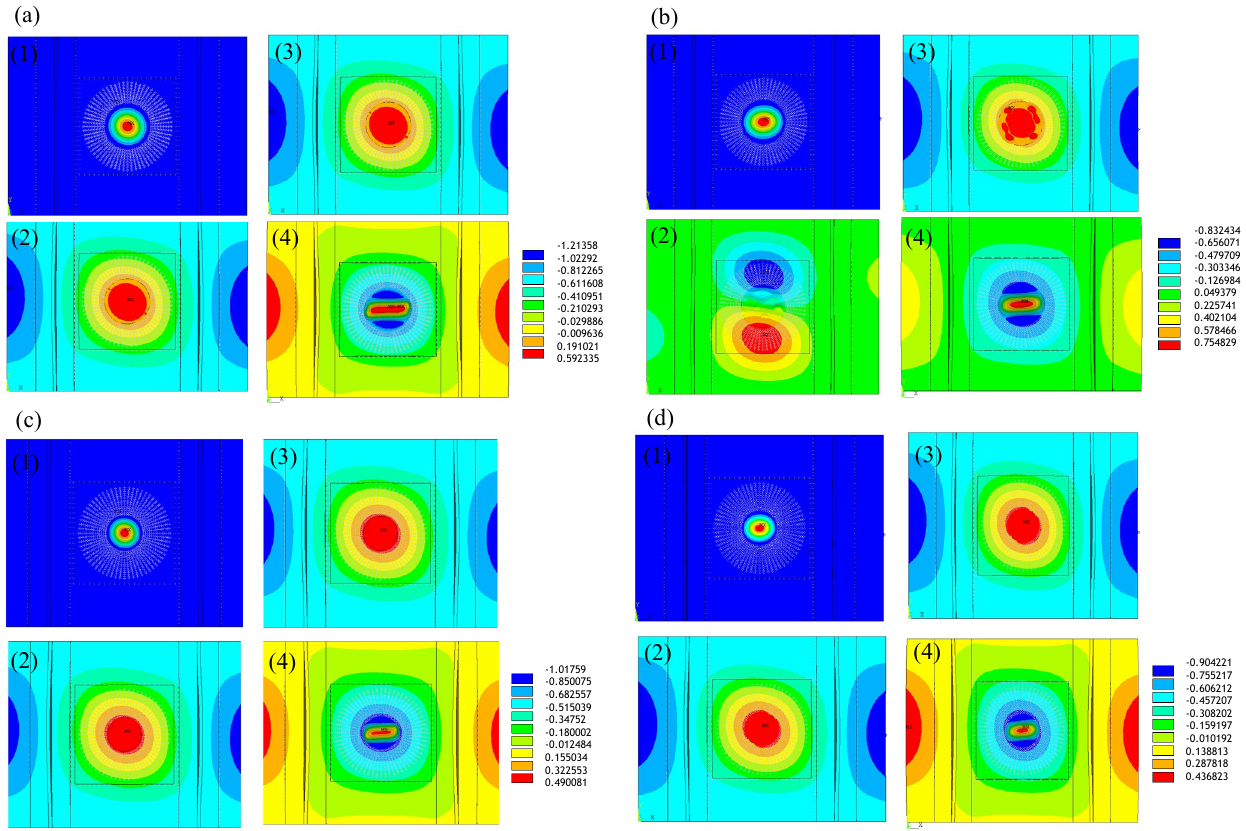
Figure 7. Out-of-plane displacement contour plot: (1) buckling of circular delamination, (2) buckling of the skin, ( 3) global buckling including stringers and (4) delamination initiation, with ( a ) CD5, ( b ) CD6, ( c ) CD7 and ( d ) CD8.